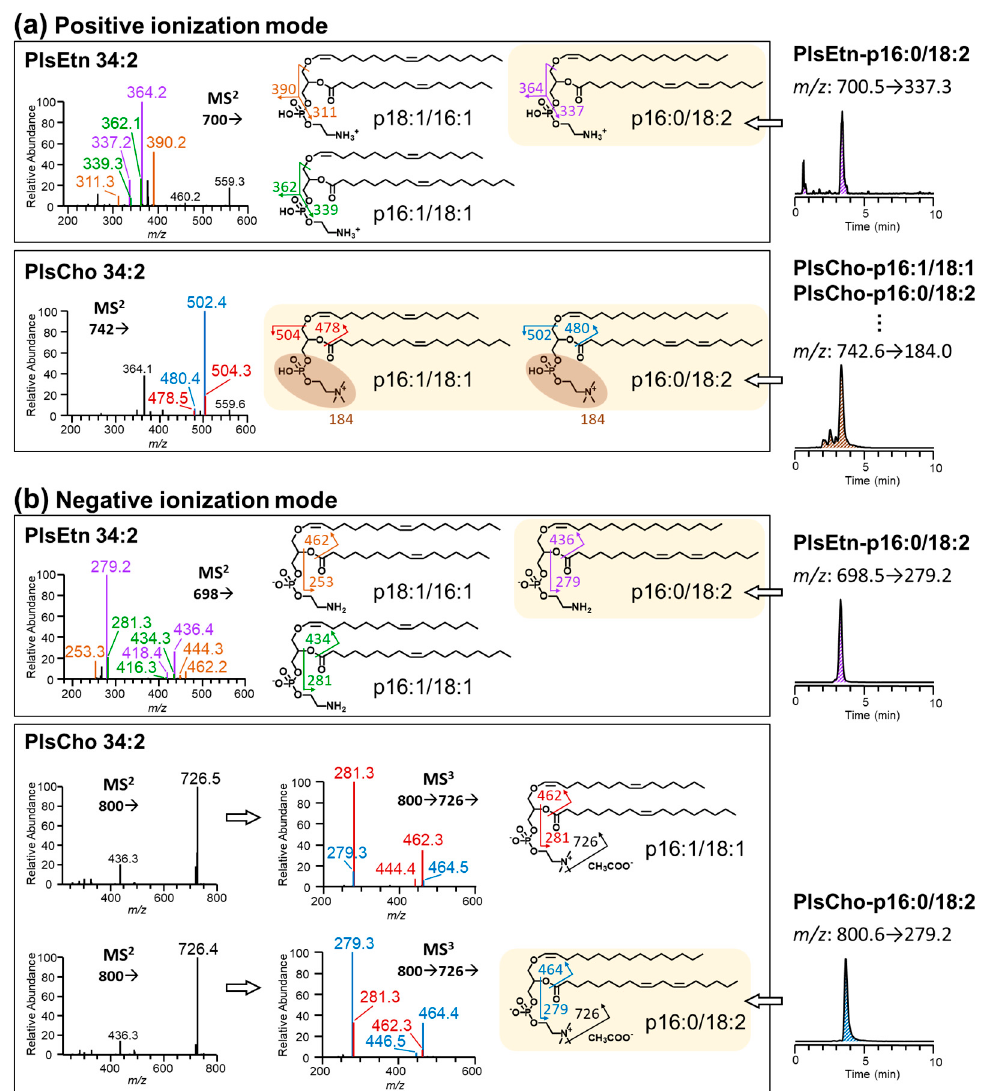
Figure 2. Identification for the isomer mixture of ethanolamine and choline plasmalogen in foodstuff samples by Orbitrap tandem MS, taking PlsEtn 34:2 (ethanolamine plasmalogen) and PlsCho 34:2 (choline plasmalogen) as examples. ( a ) Tandem MS fragmentation under positive ionization mode; ( b ) Tandem MS fragmentation under positive ionization mode. The structures indicate the existed isomers with different sn -1 and sn -2 fatty chains identified by MS 2 and MS 3 . And the chromatograms on the right side were acquired by triple quadrupole MS/MS under the optimized MRM conditions for the analytes,